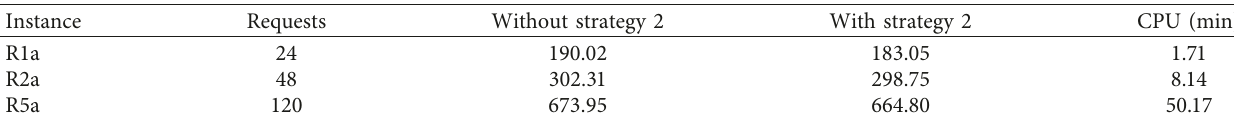
Table 9: Results of Strategy 2 or not.